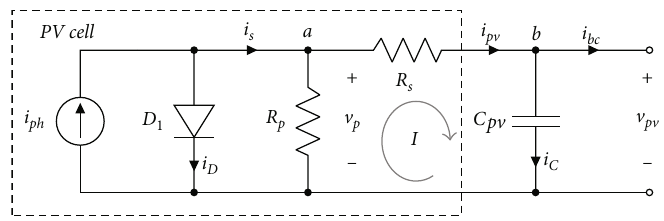
Figure 1: Electric diagram of the PV cell with DC-link capacitor C